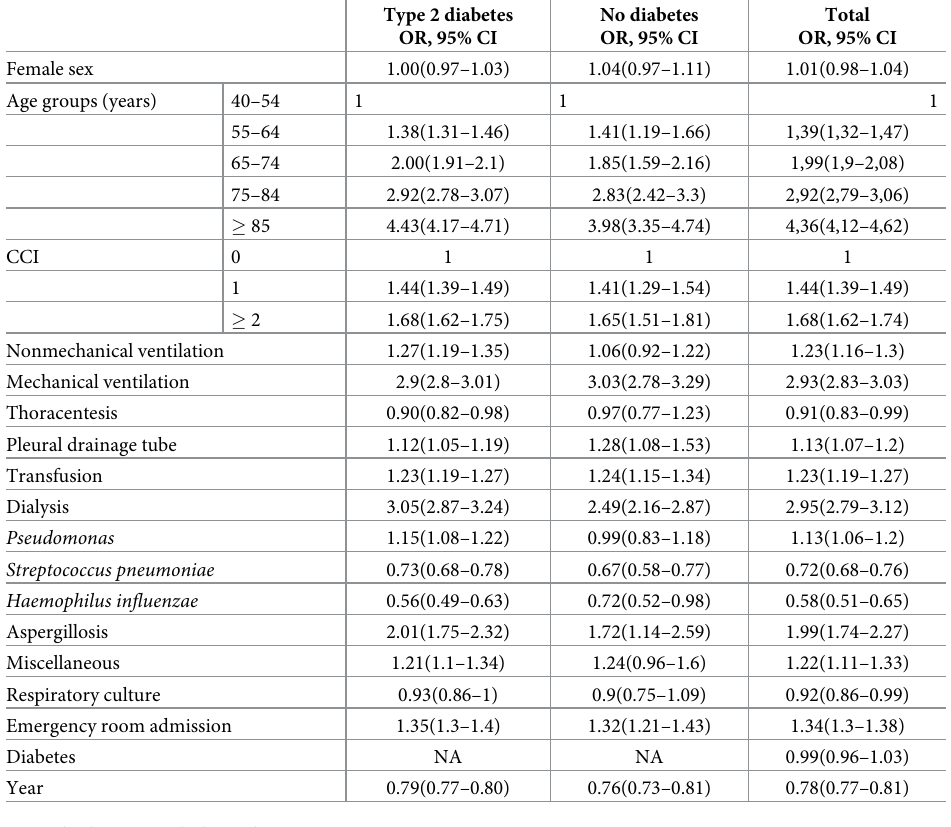
Table 5. Factors independently associated with in-hospital mortality among hospitalized diabetic and nondiabetic patients who suffered from postsurgical pneumonia according to hospitalization survival in Spain,